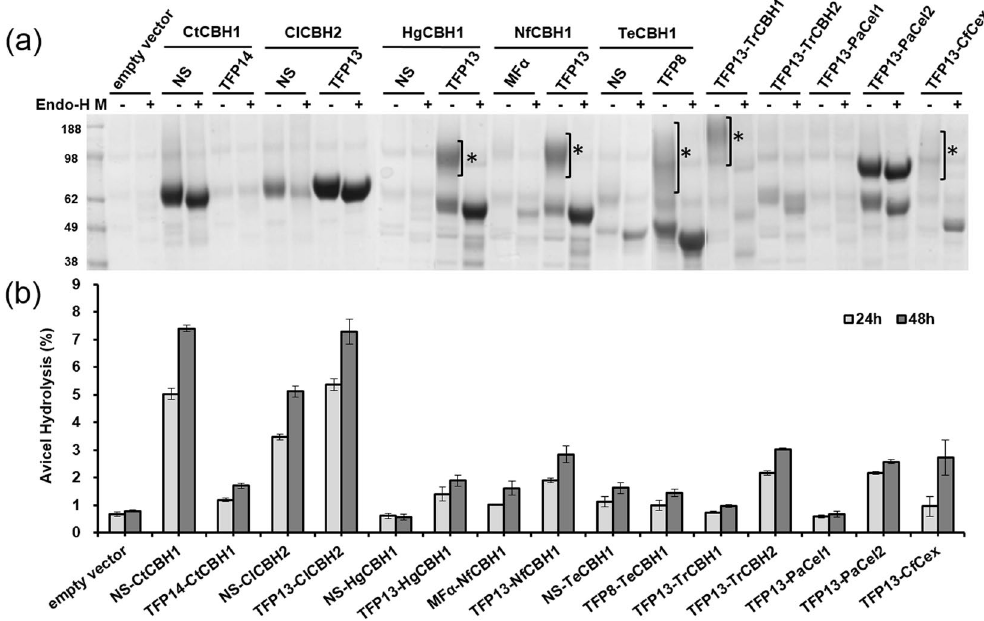
Figure 3. Secretion of exo-cellulases in S. cerevisiae . ( a ) Secretion of CBHs was analysed by SDS-PAGE using 100 μ L of the test tube culture supernatants after freeze-drying. All samples were treated with ( + ) or without ( − ) endo-H for deglycosylation. The asterisks indicate the hyperglycosylated cellulases. ( b ) The degree of Avicel hydrolysis was detected based on the amount of glucose released by secreted CBHs with 0.5% (v/v) Novozyme A188 in 24 h (grey bars) and 48 h (black bars). Activity was expressed as the percentage of Avicel hydrolysed, as described previously 12 . Experiments were performed in triplicate and repeated three times.